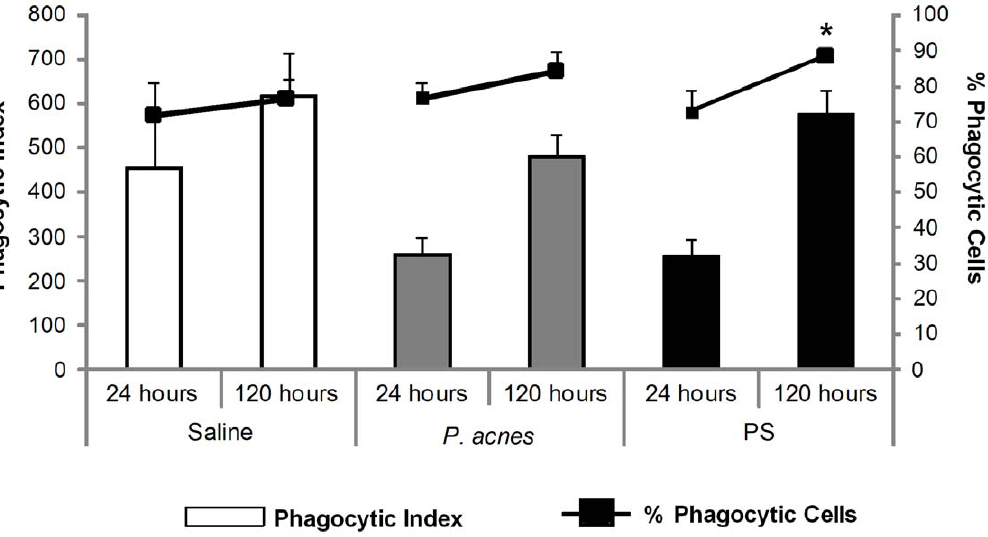
Figure 6. Evaluation of B-1CDP cell phagocytic activity. B-1b cells from the supernatant of 5 day-old cultures from the saline (control group), P. acnes and PS groups were re-cultured for 24 or 120 hours to differentiate into phagocytes (B-1CDP). Saccharomyces cerevisiae cells were added to the B-1CDP cells after each time point, and the phagocytic function was determined from the phagocytic index (bars) and the percentage of phagocytic cells (lines). * p , 0.05 between the control and PS groups at 120 hours (percentage of phagocytic cells).